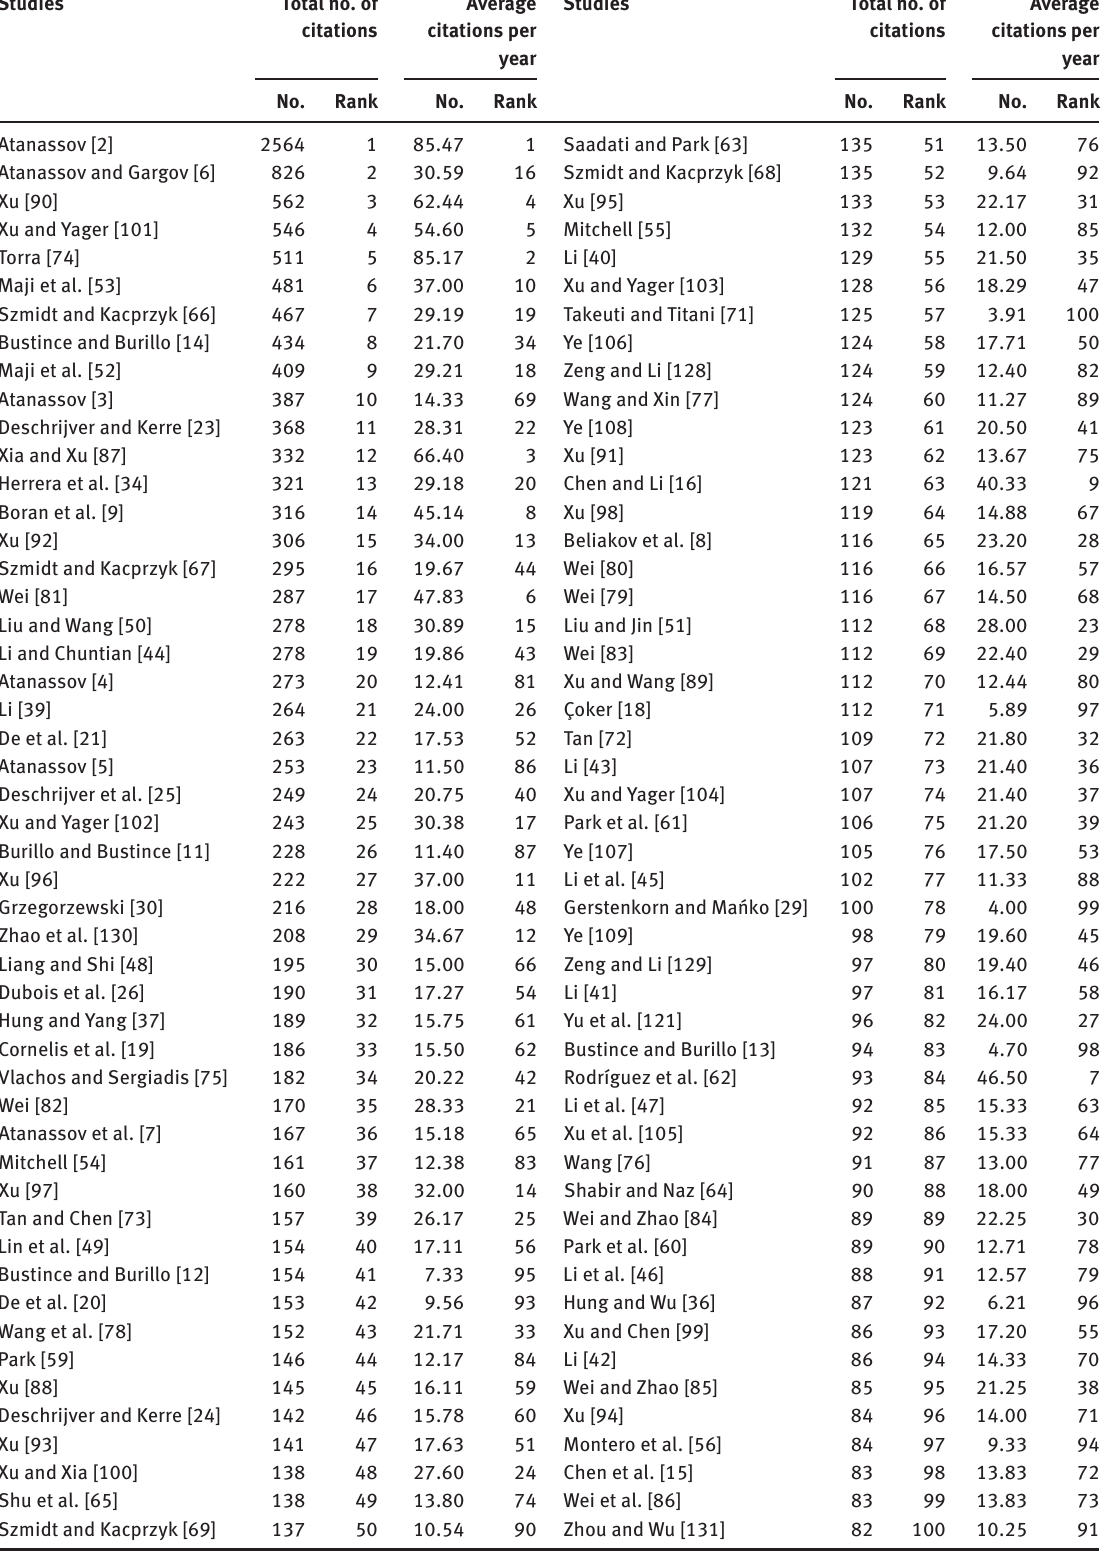
Table 1: Top 100 Cited Papers in Intuitionistic